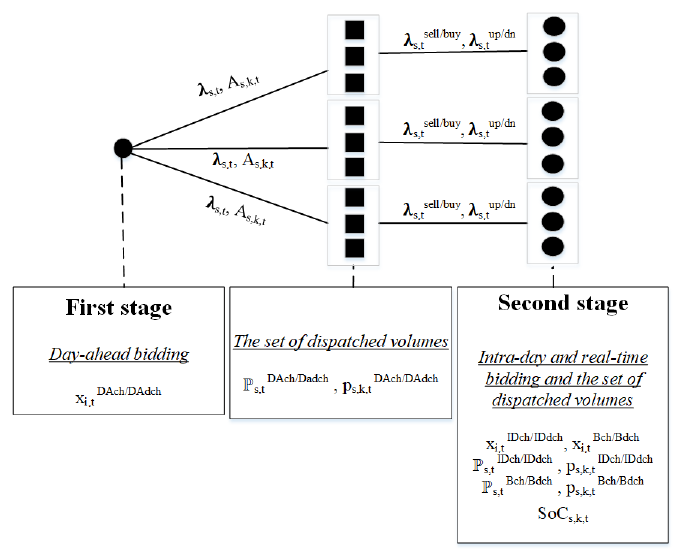
Figure 1. Decision process